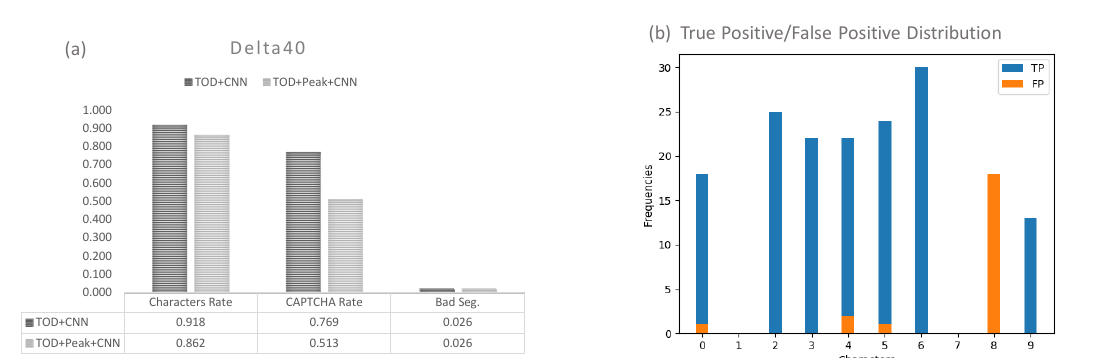
Figure 12. Test Results over External Benchmark HashKiller13.